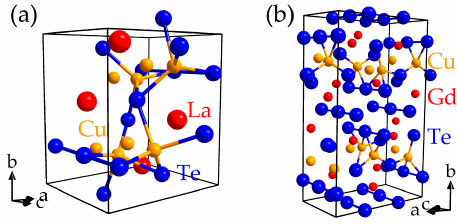
Figure 4. Representations of the crystal structures of: ( a ) LaCu x Te 2 (0.28 ≤ x ≤ 0.50); and ( b ) Gd 3 Cu 2 Te 7 , which comprise linear undistorted tellurium chains (see main text).